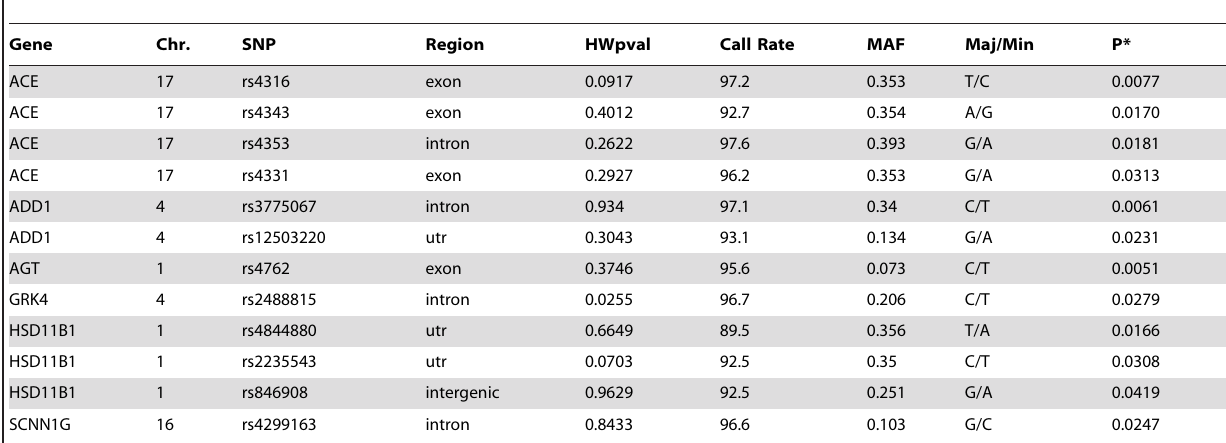
Table 2. SNPs that showed significant associations with eGFR in GenSalt participants.